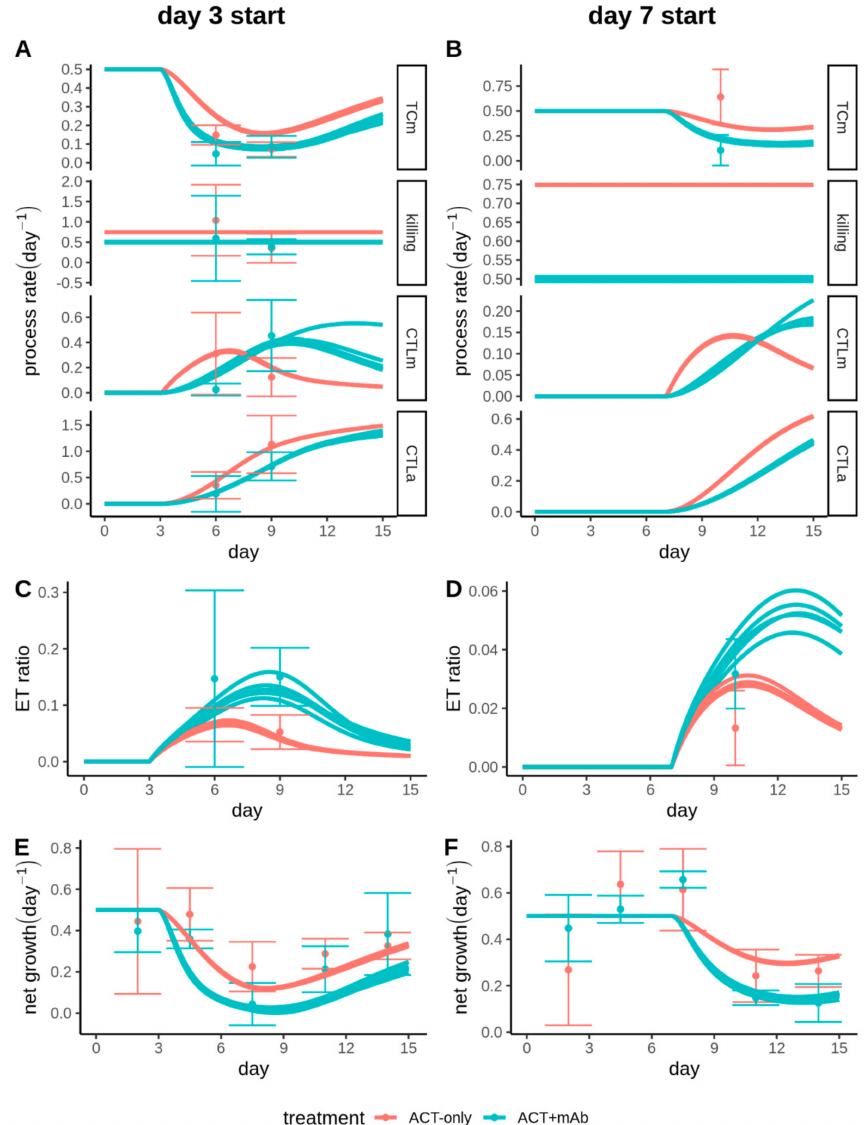
Figure 5. Enhanced antiproliferative effect and extended effector window of CD137 stimulated CTLs. ( A – F ) Results of parameter estimation. Model output represented by lines, data plotted as mean and s.d. Shown are observed and fitted process rates ( A , B ), effector:target ratio ( C , D ) and net tumour growth ( E , F ) for either tumours treated on day 3 ( A , C , E ) or day 7 ( B , D , F ). Process rates considered in ( A , B ) are: TCm (Tumour Cell mitosis); killing (of tumour cells by CTLs); CTLm (CTL mitosis); CTLa (CTL